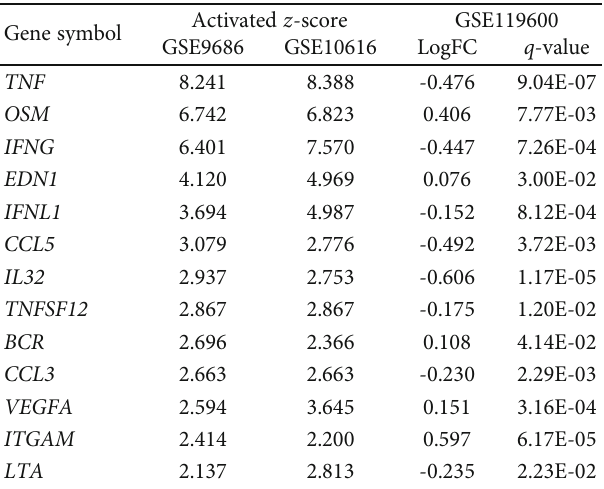
Table 5: The expression level of genes in whole blood cells, which were predicted to be upstream regulators in colonic